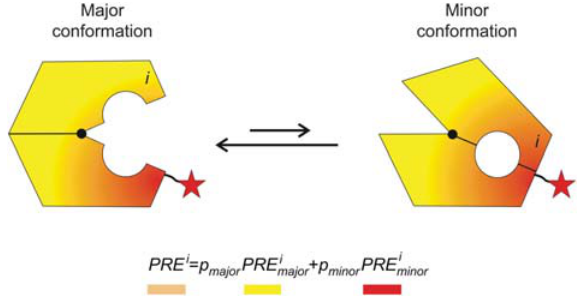
Figure 4 Paramagnetic NMR strategy for structure determination of a minor closed-unliganded PBP conformation in equilibrium with a major open one. A red star represents a spin label, chemically connected to the ‘lip’ of one domain. The induced distance-depend- ent paramagnetic relaxation enhancement (PRE) on the protein is graphically indicated via a color gradient, red being the strongest and yellow the weakest. PRE i , the measured PRE on site i , located in the domain that does not contain the label, considerably reflects that from the minor conformation ( ) despite the low pop- i PRE minor ulation of the latter ( p ). Symbols labeled ‘ major ’ refer to the minor 4 p ) and are anal- major conformation (with population p major minor ogous to those associated with the minor species. Although a bal- ancing interface such as that in MBP is implied, it might not apply to all PBPs (14).